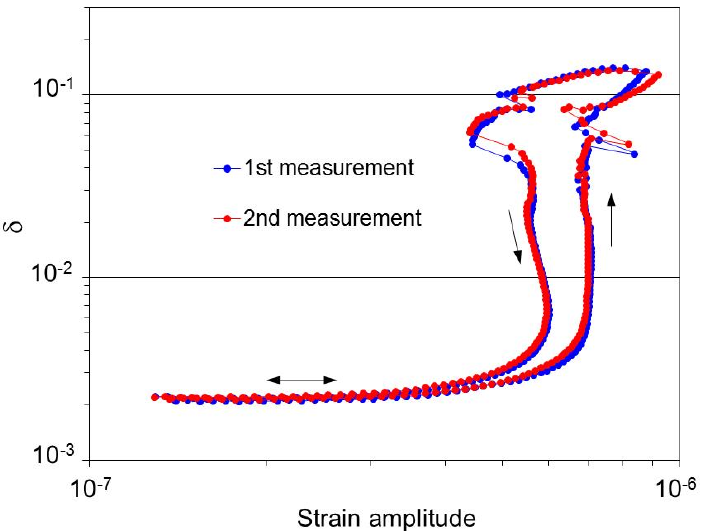
Figure 3. Strain amplitude dependence of the internal friction for a Structure 1 sample with one highly mobile (Type II) and one low mobility (Type I) a/c twin boundaries. Two consecutive measurements at room temperature (290 K), arrows indicate the scans with increasing and decreasing strain amplitude.